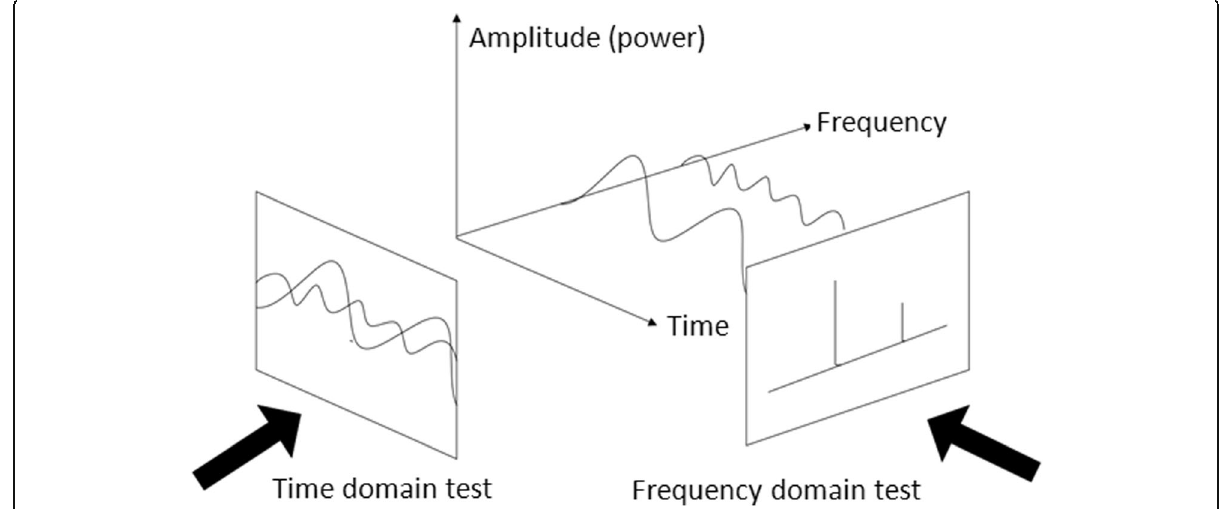
Fig. 1 Diagram of the time domain and frequency domain of the signal